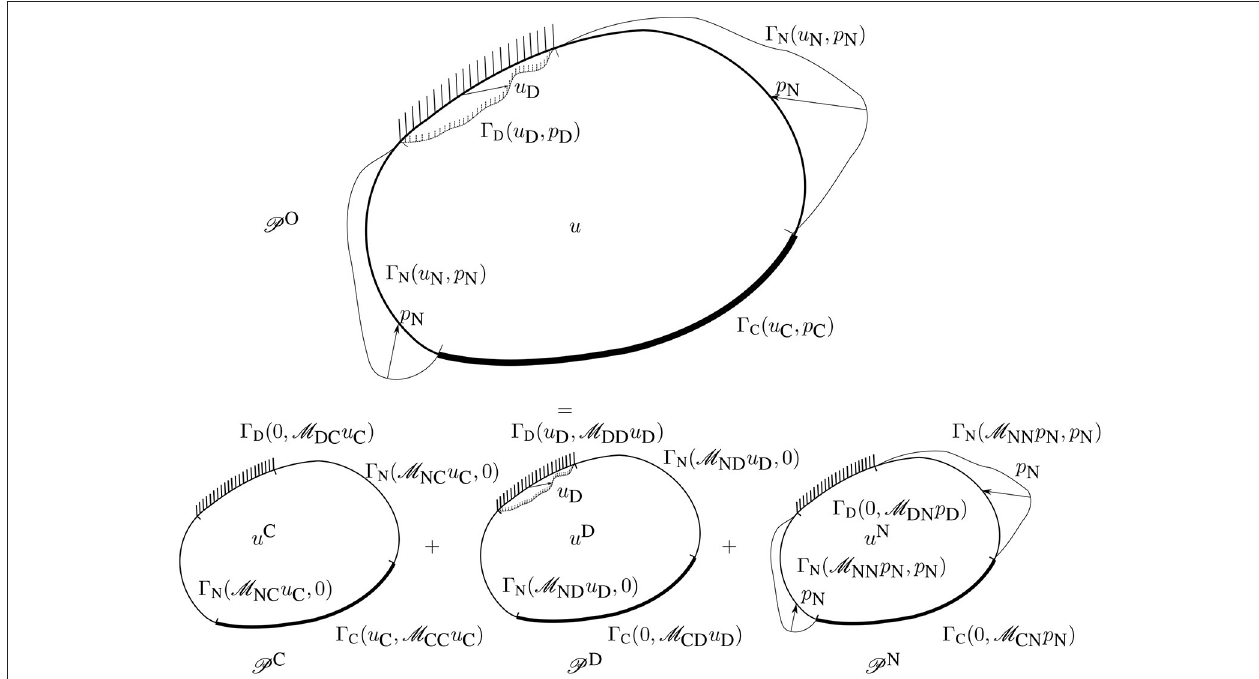
FIGURE 4 | Solution of a mixed BVP P O for a single elastic domain given as a superposition of the solutions of the three sub-problems P C , P D and P N